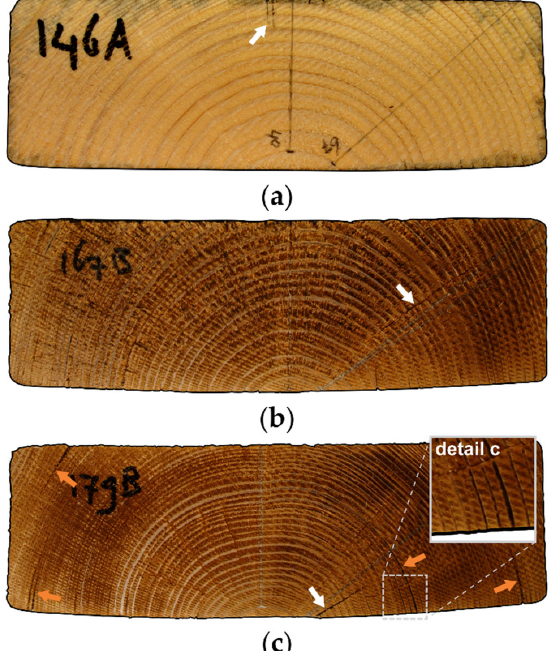
Figure 4. Examples of checks across (white arrows) and along (orange arrows) growth rings in crosscuts of ‘exposed’ boards after weathering: ( a ) control board with checks across rings on bark side, ( b ) TM board with internal checks across rings and ( c ) TM board with checks along and across annual rings on pith and bark side.